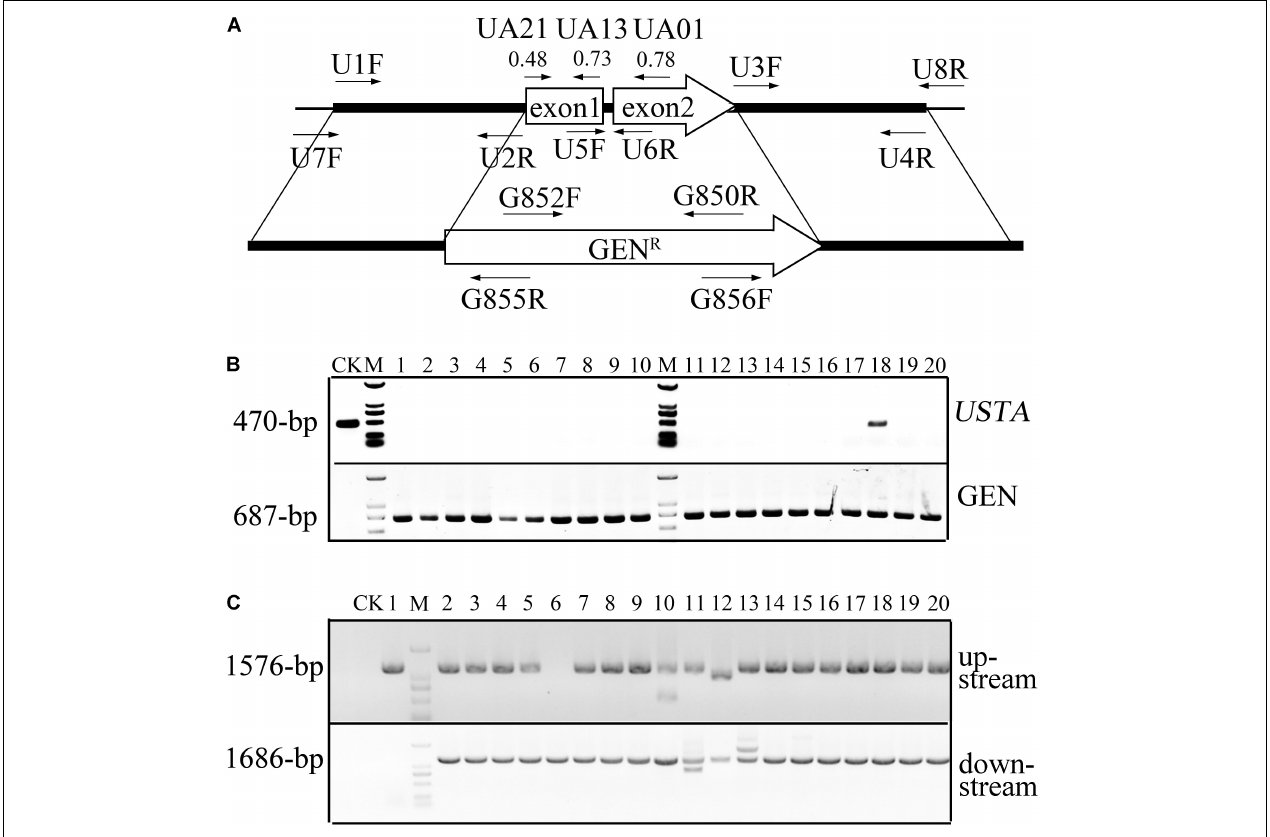
FIGURE 2 | The USTA gene and deletion mutants. (A) The USTA gene and gRNA spacers. The position and direction of gRNA spacers and primers used to generate and screen ustA deletion mutants are marked with arrows. The on-target scores of spacers UA01, UA13, and UA21 are labeled in the bracket. (B) PCR assays for the deletion of USTA (upper panel) and presence of the geneticin-resistance gene (lower panel) in 20 transformants generated with pCas9-tRp-gRNA-UA01 (spacer UA01). The 470-bp USTA fragment was only amplified in the wild-type (CK) and transformant 18. M: 1-kb DNA ladder marker. (C) PCR assays to verify gene replacement events in 20 putative ustA deletion mutants. The 1576-bp upstream and 1686-bp downstream recombination products were amplified with primer pairs USTA7F(U7F)/G855R and USTA8R(U8R)/G856F, respectively. Amplification with P1 was used as the negative control. M: 1-kb DNA ladder